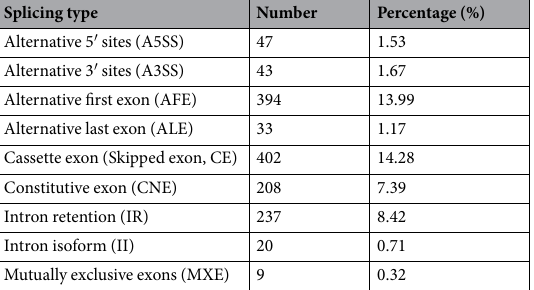
Table 2. Alternative splicing event types in PDAC. CE: an exon may be spliced out of the primary transcript or retained; CNE: constitutively spliced exons. All events were based on the nomenclature described in Wang et al . 4